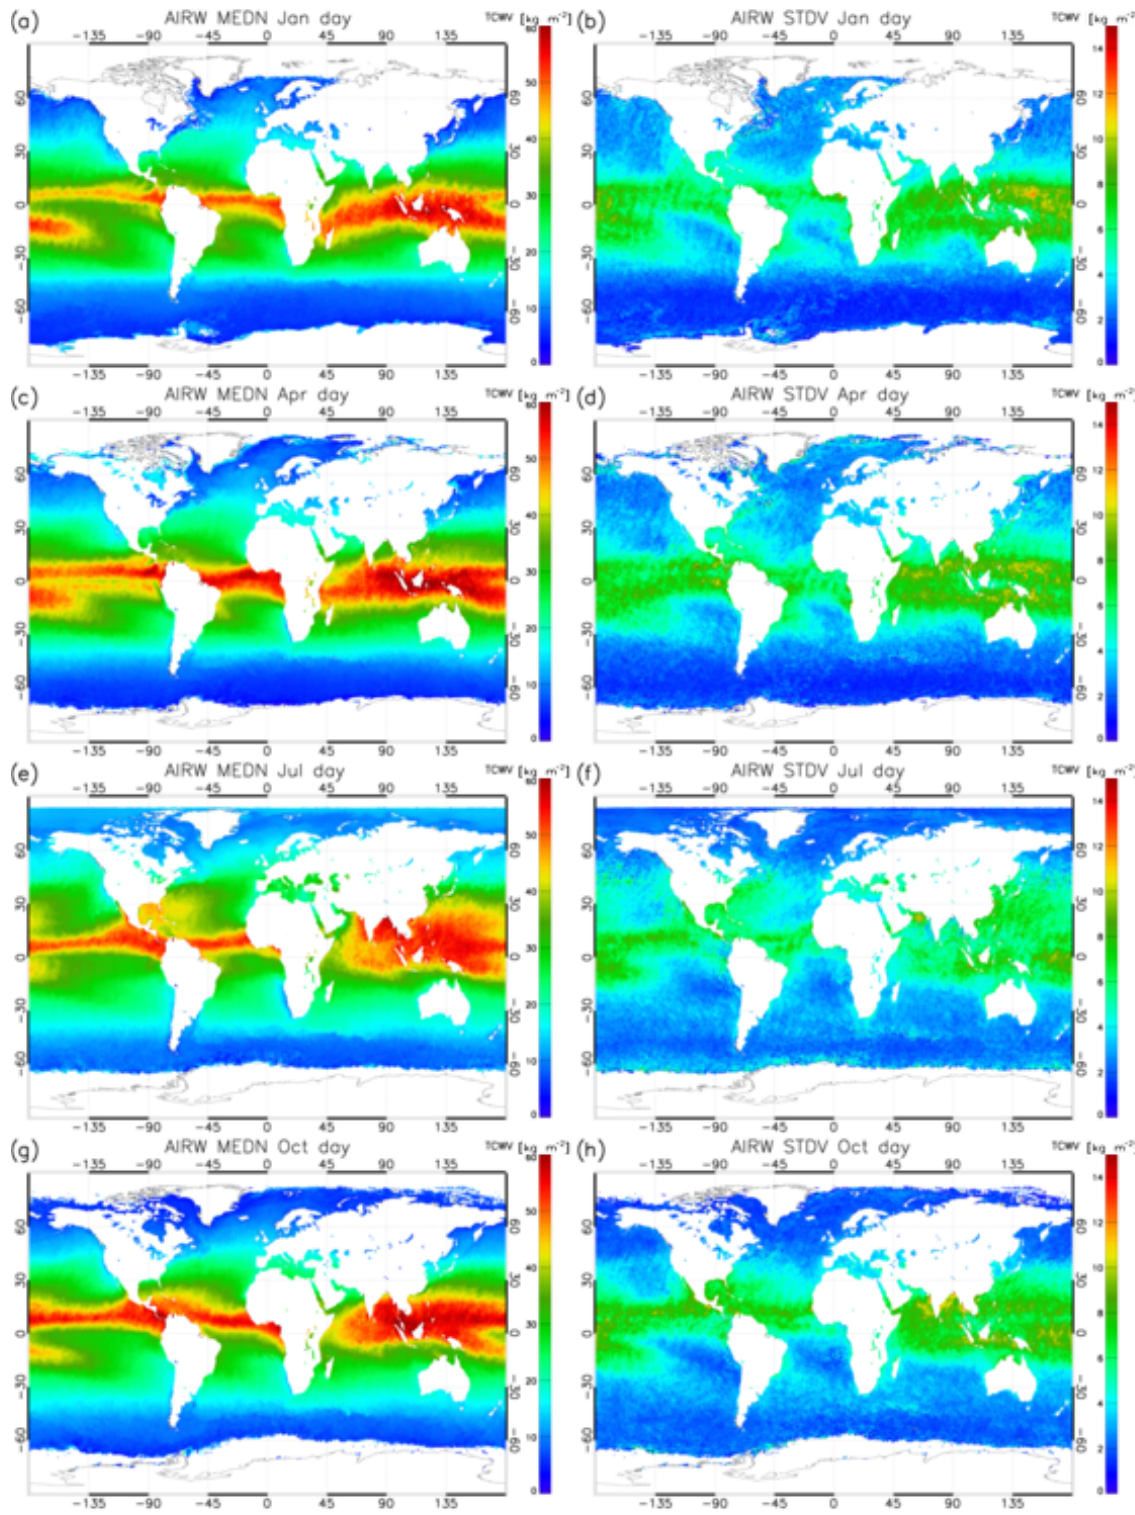
Figure 3. Climatology of daytime TCWV from the AIRWAVEv2 dataset for January (a) , April (c) , July (e) and October (g) from 1991 to 2012, and standard deviations for the same months ( b, d, f, h